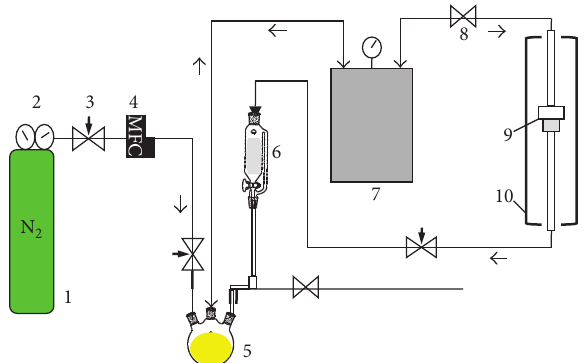
F 1: Schematic representation of the H